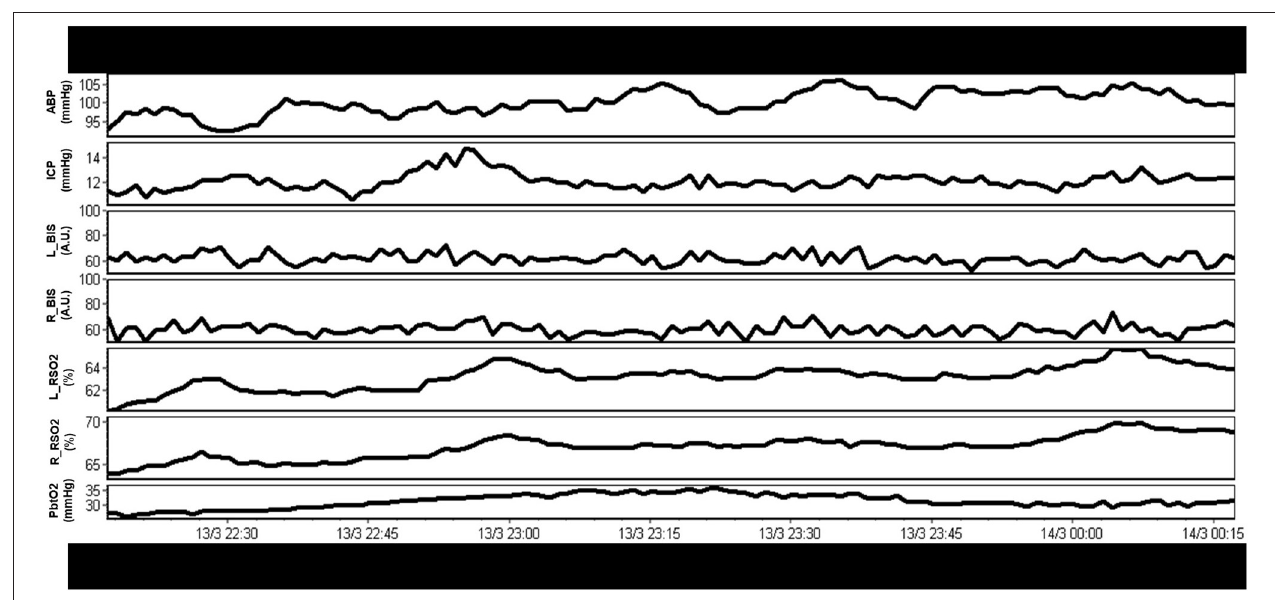
FIGURE 1 | Example of raw continuous multi-modal cerebral physiologic monitoring in moderate/severe TBI. A rich variety of continuous physiologic parameters are currently monitored, however, interpretation of these raw parameters in concert is complex. A.U., arbitrary units; ABP, arterial blood pressure; BIS_L, bispectral index on left hemisphere; BIS_R, bispectral index on right hemisphere; ICP, intracranial pressure; mmHg, millimeters of Mercury; rSO 2 _L, regional oxygen saturations on left frontal lobe (using near infrared spectroscopy); rSO 2 _R, regional oxygen saturations on right frontal lobe (using near infrared spectroscopy); PbtO 2 , extracellular partial pressure of oxygen in the brain tissue; TBI, traumatic brain injury; %, percent. Data taken from previously published and approved studies (University of Manitoba REB: H2017:181, H2017:188 and H2020:118) ( 9, 10, 32–35).